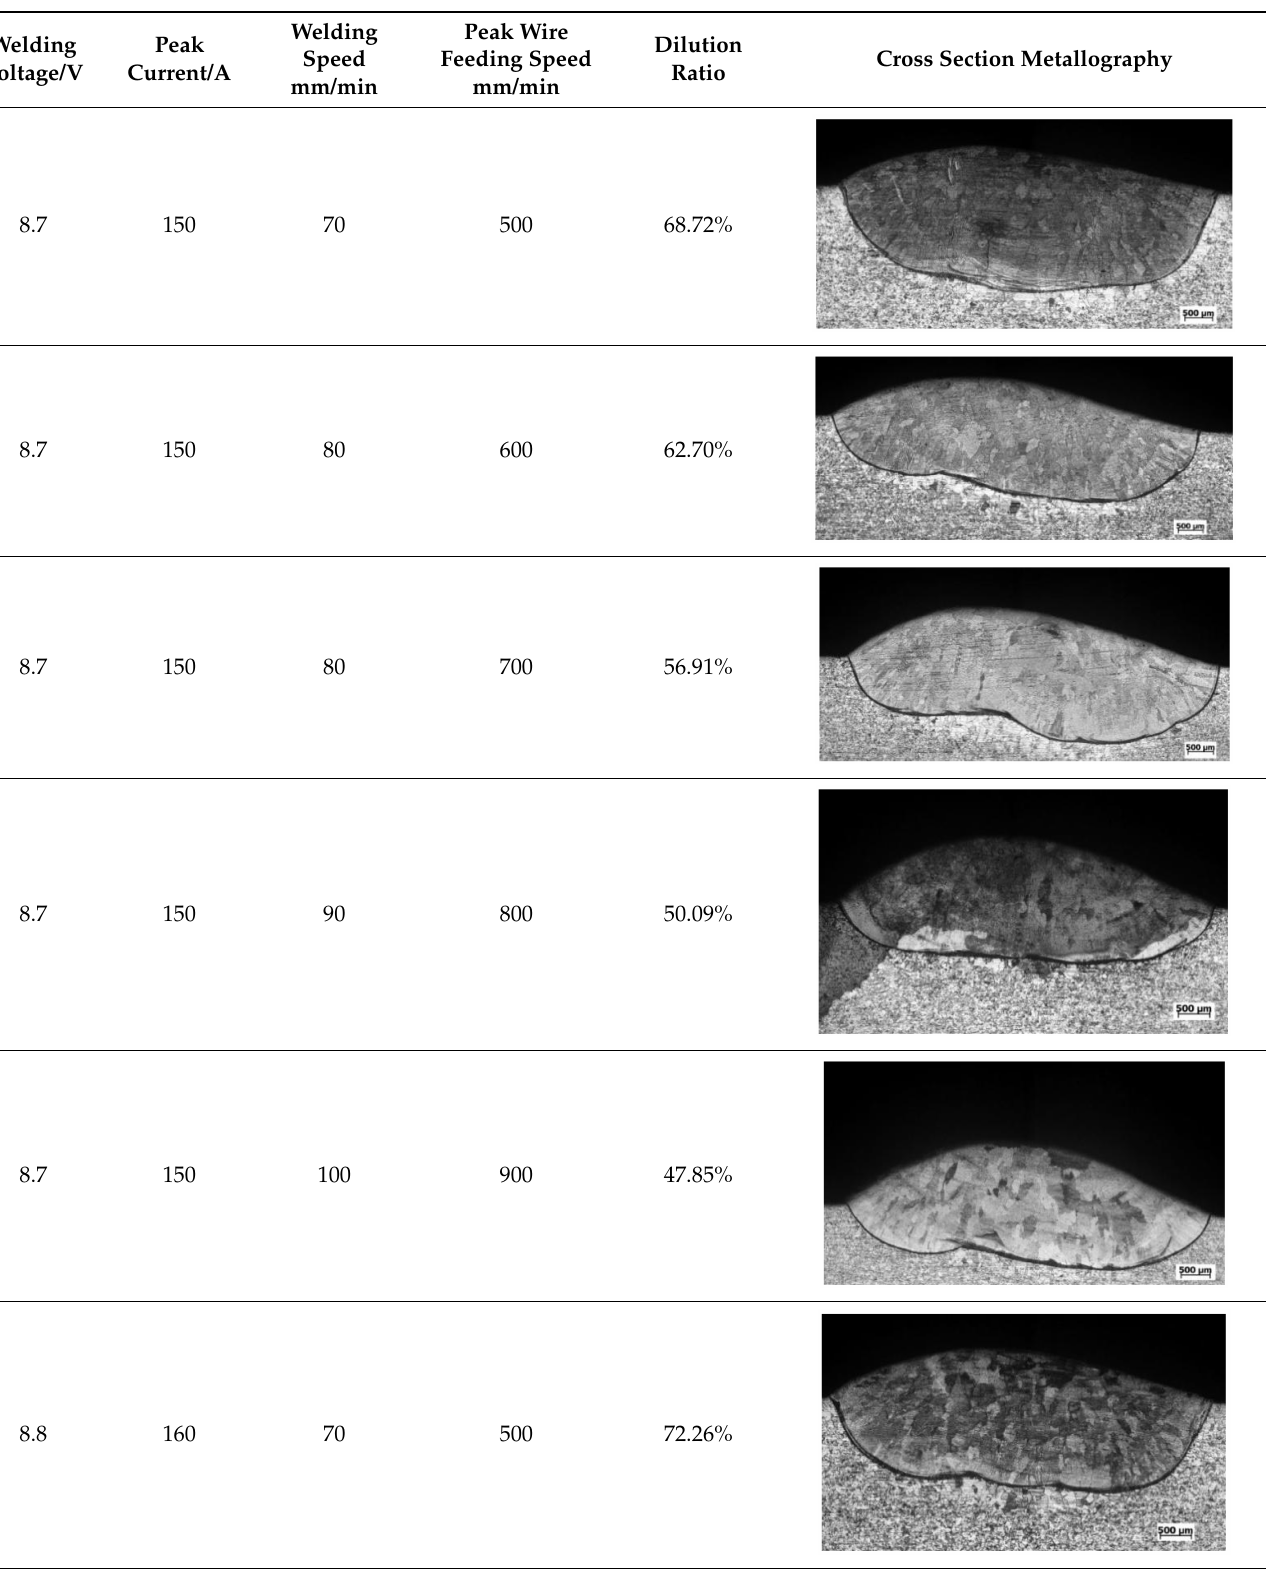
Table 1. Dilution ratio under different welding